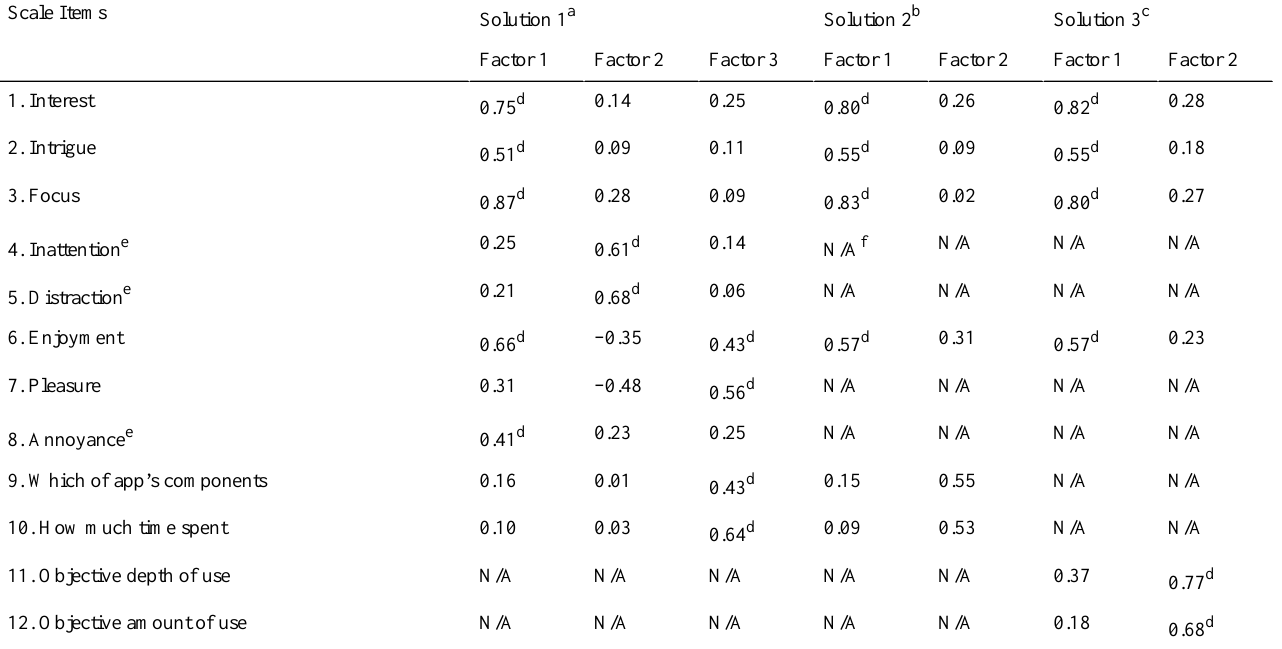
Table 4. Factor loadings of the DBCI Engagement Scale in exploratory factor